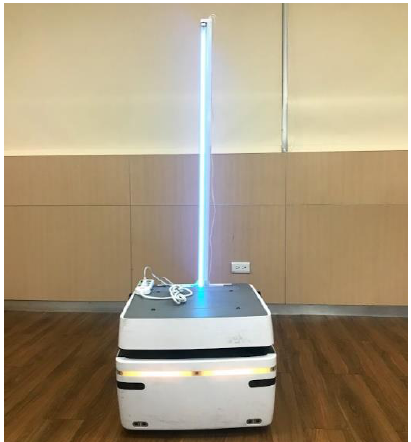
Figure 2. Photo of the disinfection vehicle with UVC lamp.